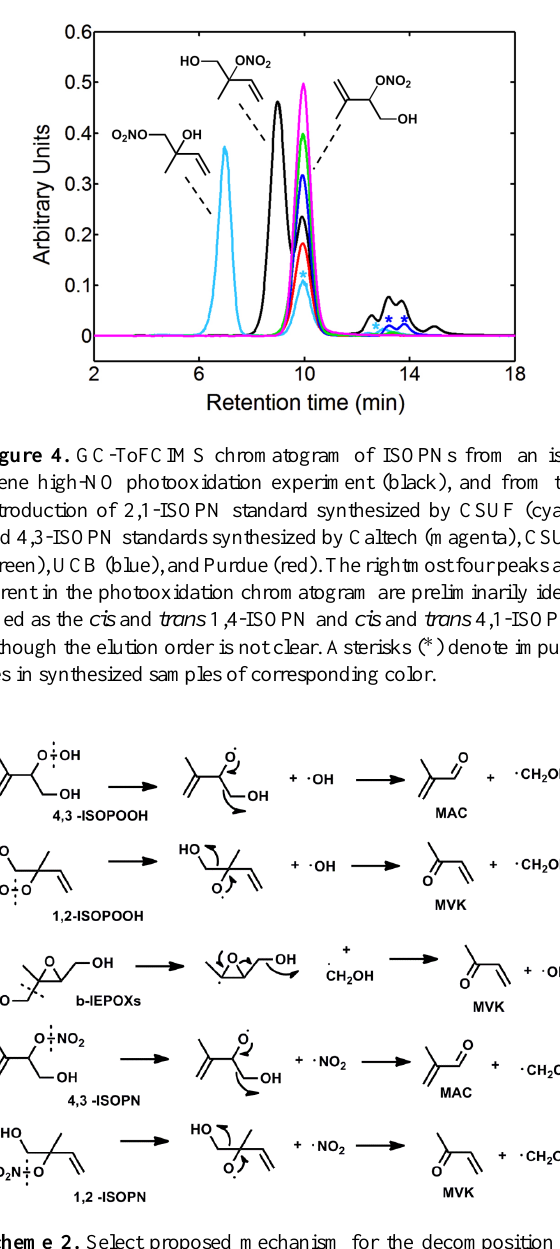
Scheme 2. Select proposed mechanism for the decomposition of OVOCs to carbonyls on contact with metal surfaces or high ion- ization energies within instrumentation. Other decomposition path- ways likely exist and the branching ratios are dependent on instru- ment operation conditions. Cleavage sites are indicated by dashed